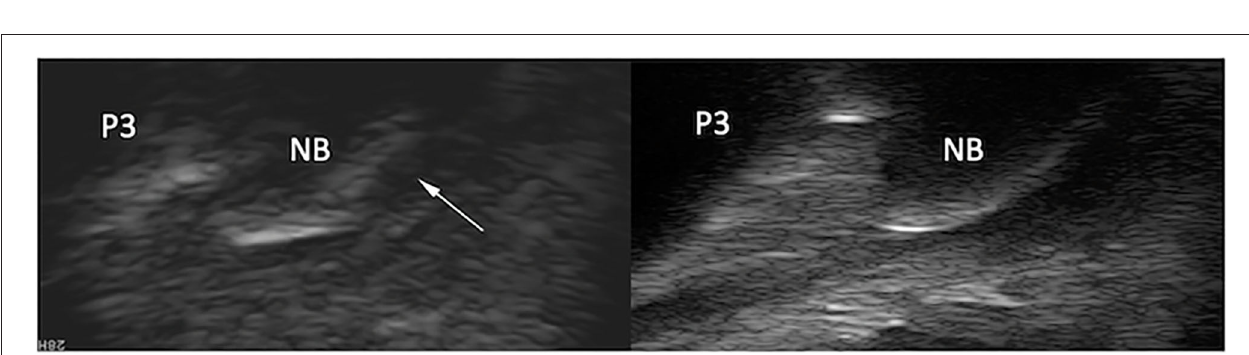
FIGURE 5 | Longitudinal transcuneal ultrasonographic image of the same front foot than Figure 4 (left) and comparative image of a normal navicular bone (right). Only the distal aspect of the navicular bones is visible on the ultrasonographic images. The images have been flipped vertically to obtain the same orientation than the MR images. The erosive defect is characterized by disruption of the normal hyperechoic bone profile and deep penetrating echoes (arrow).